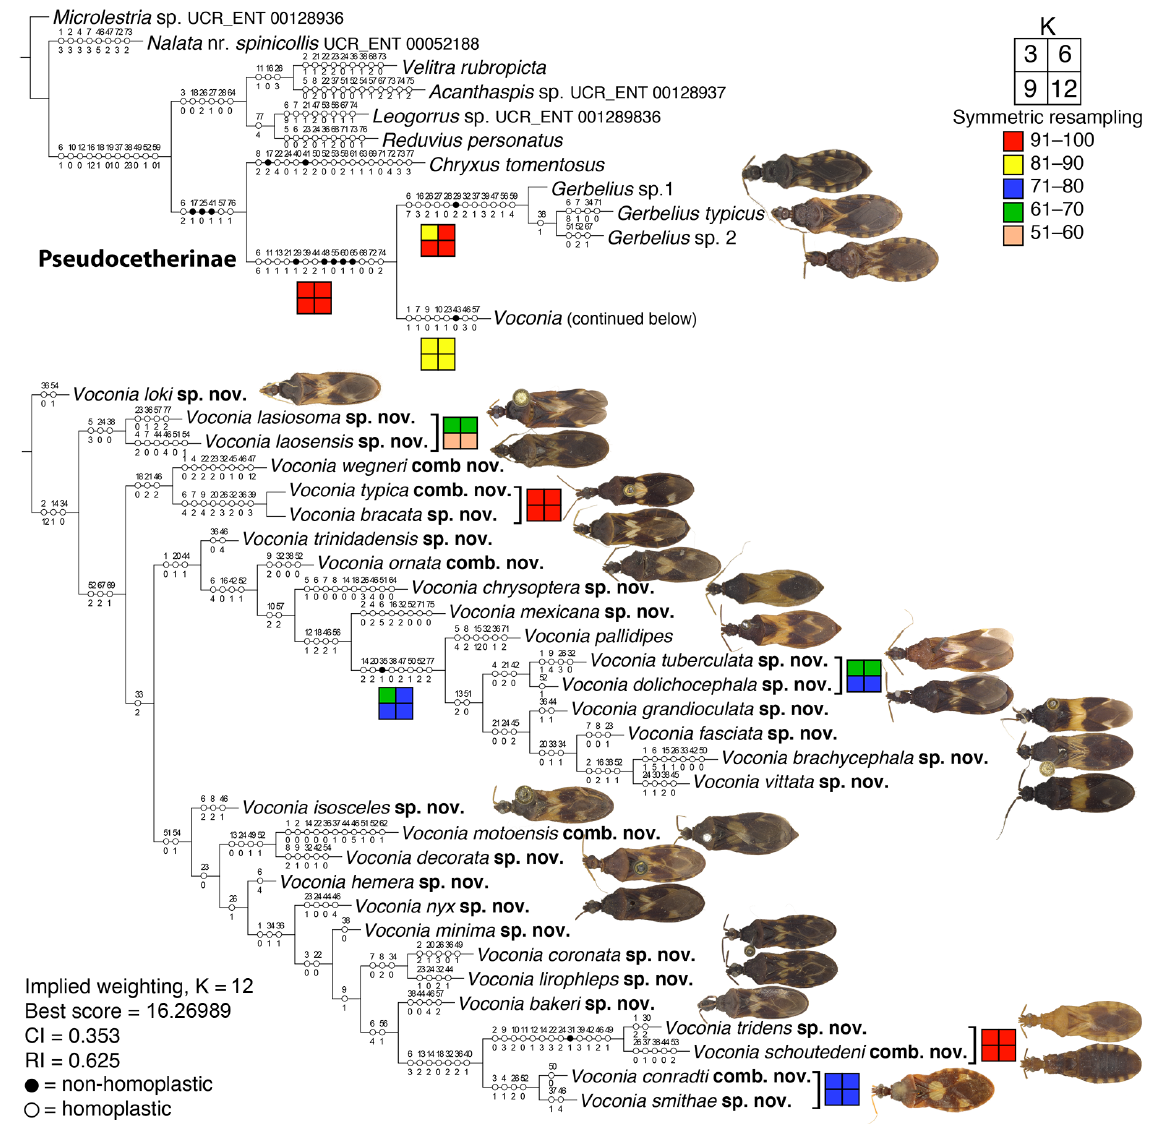
Fig. 2. Tree resulting from implied weighting analysis using K = 12 with characters unambiguously optimized. Symmetric resampling values over 51 are represented for trees obtained with K = 3, K = 6, K = 9, and K = 12 analyses. Characters and character states are described in pp. 11–22. Specimens not to